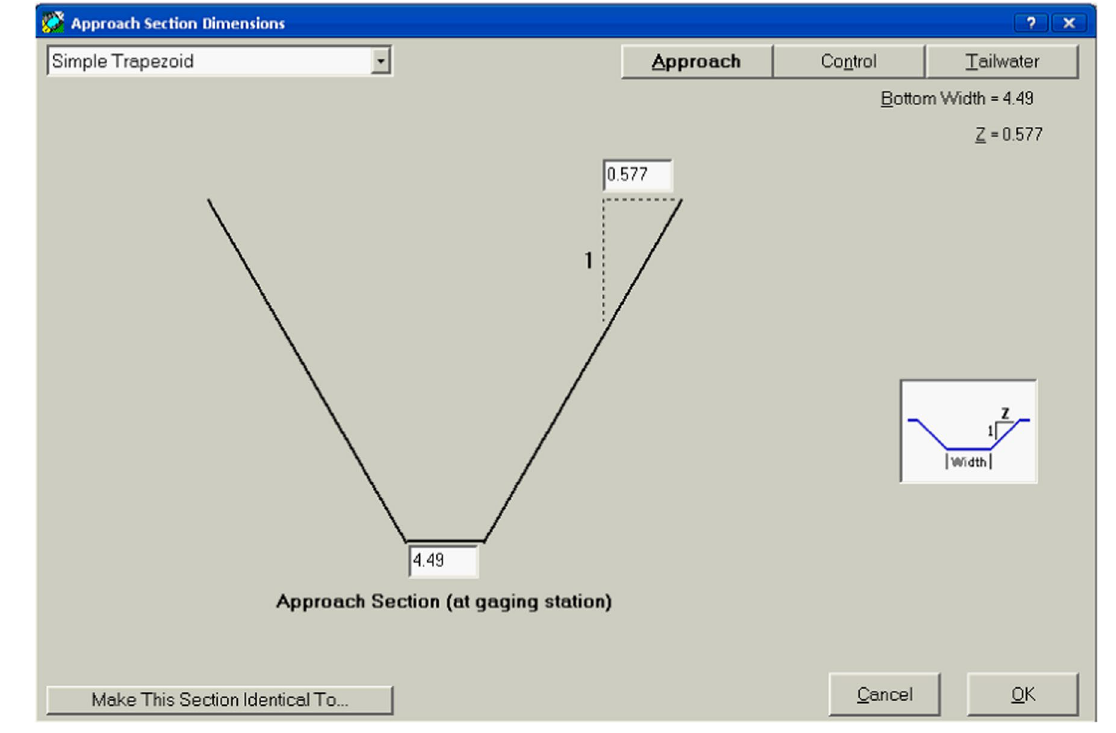
Fig. 5 Simulation of flume sections according to the width of the sections and the slope of the